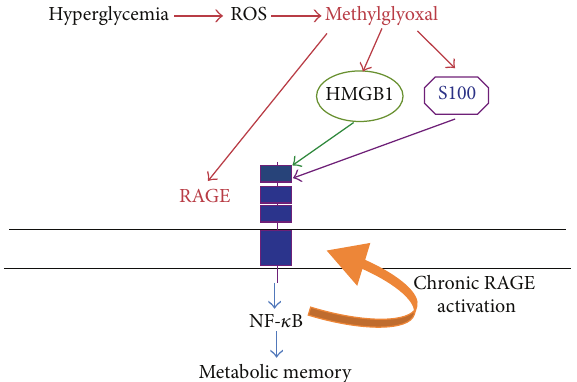
Figure 4: RAGE-dependent metabolic memory. RAGE also contributes to the establishment of the metabolic memory. Hyperglycemia-induced ROS formation leads to the production of methylglyoxal, which in turn induces the expression of RAGE and its ligands S100 and HMGB1. The production of RAGE ligands further activates RAGE, leading to NF- 𝜅 B activation. NF- 𝜅 B in turn induces (i) a chronic RAGE activation, leading to chronic neurovascular inflammation; (ii) epigenetic modification of gene expression. Both pathways are implicated in the metabolic